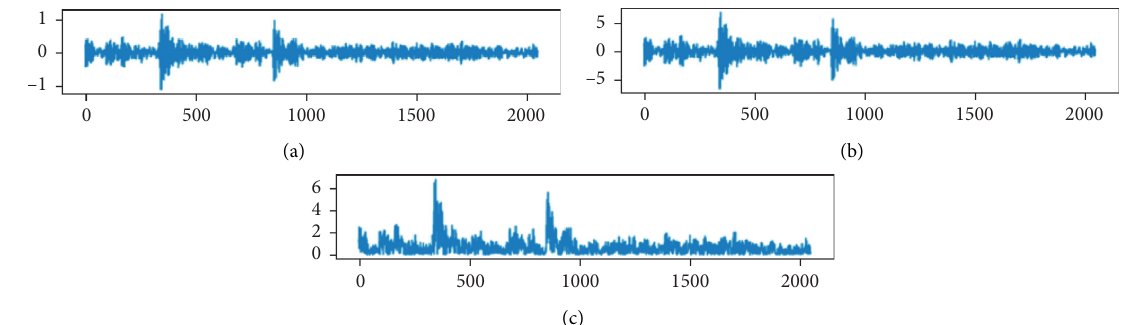
Figure 12: 0.021-inch RE fault.